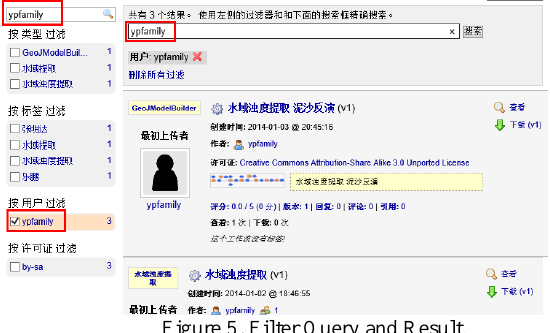
Figure 5. Filter Query and